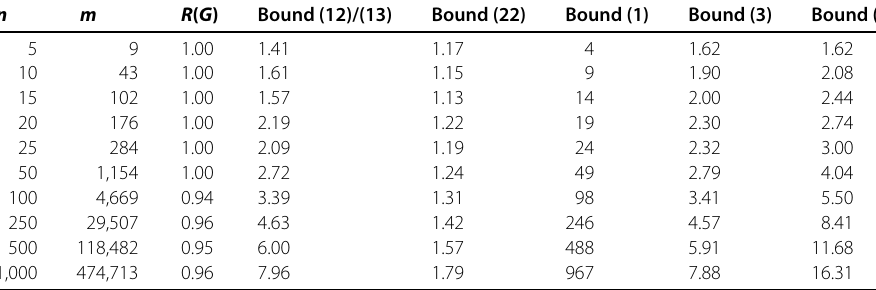
Table 2 Upper bounds of R ( G ) for graphs generated by G ER ( n ,0.9) model n m R ( G